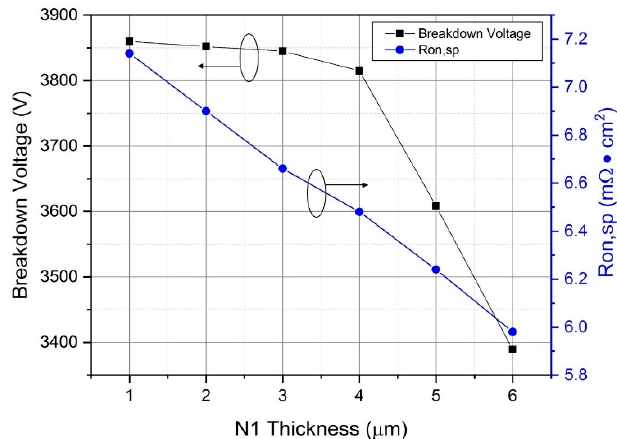
Figure 6. Relationship of different N1 epitaxial layer thicknesses and breakdown voltage and R on,sp .